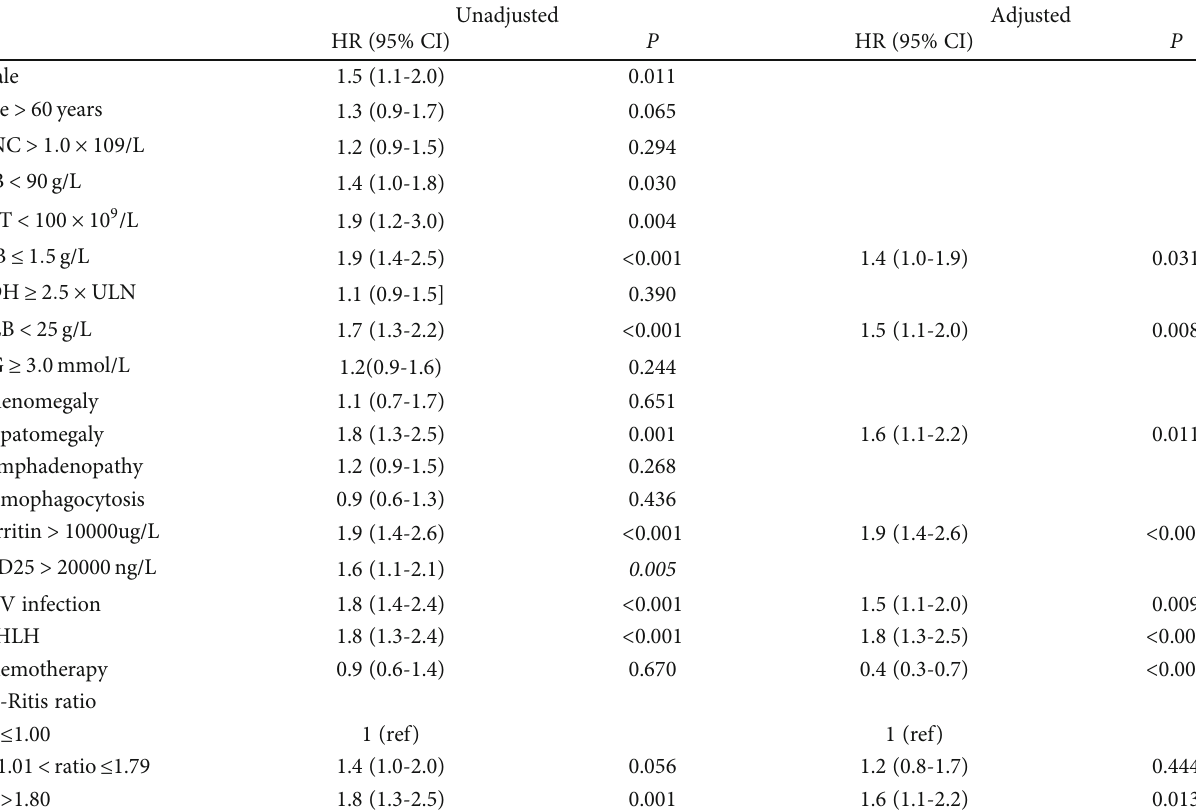
Table 2: Uni- and multivariate Cox regression analyses of overall survival.